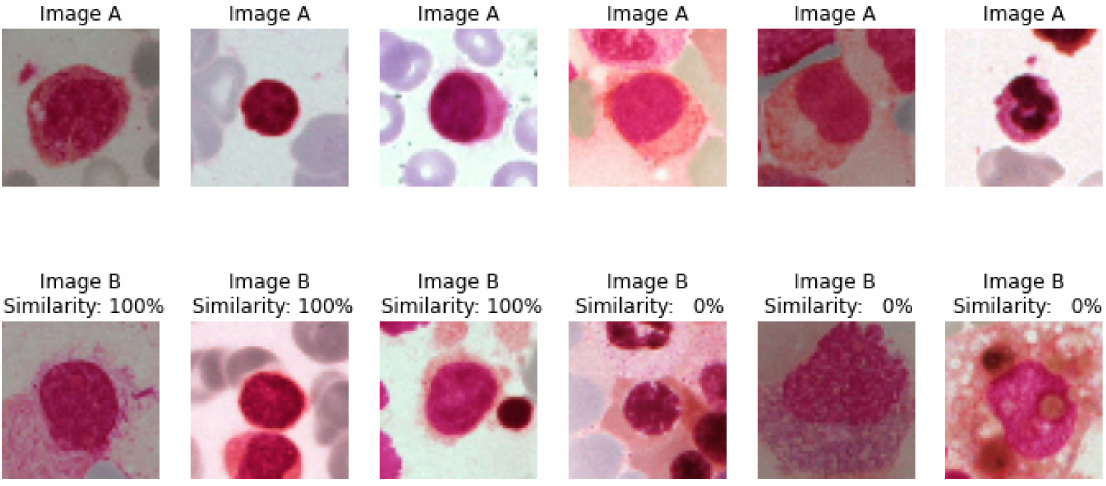
Figure 10. Output of model with percentage confidence in similarity for given pairs of anchor and test input images.